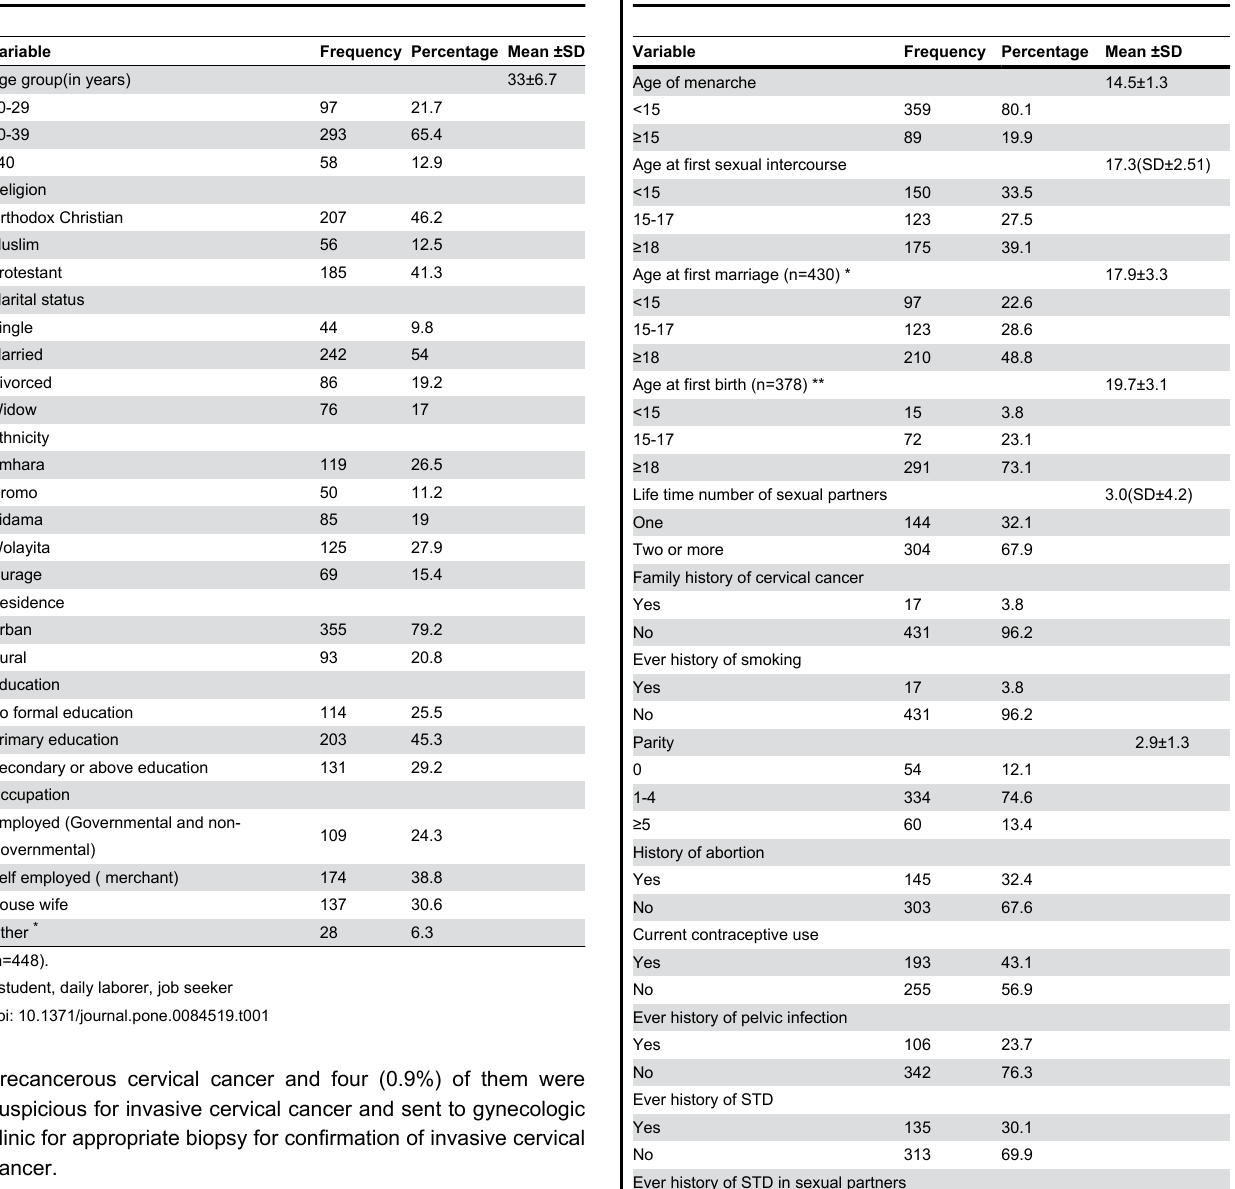
Table 1. Socio-demographic characteristics of study participants in the three screening centers, Southern Ethiopia 2013.